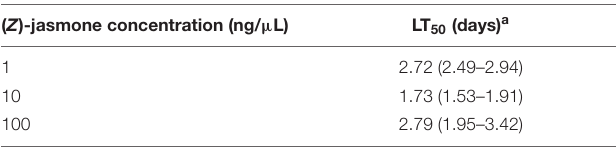
TABLE 4 | LT 50 values 7 days post-treatment of Tuta absoluta larvae exposed to different concentrations of ( Z